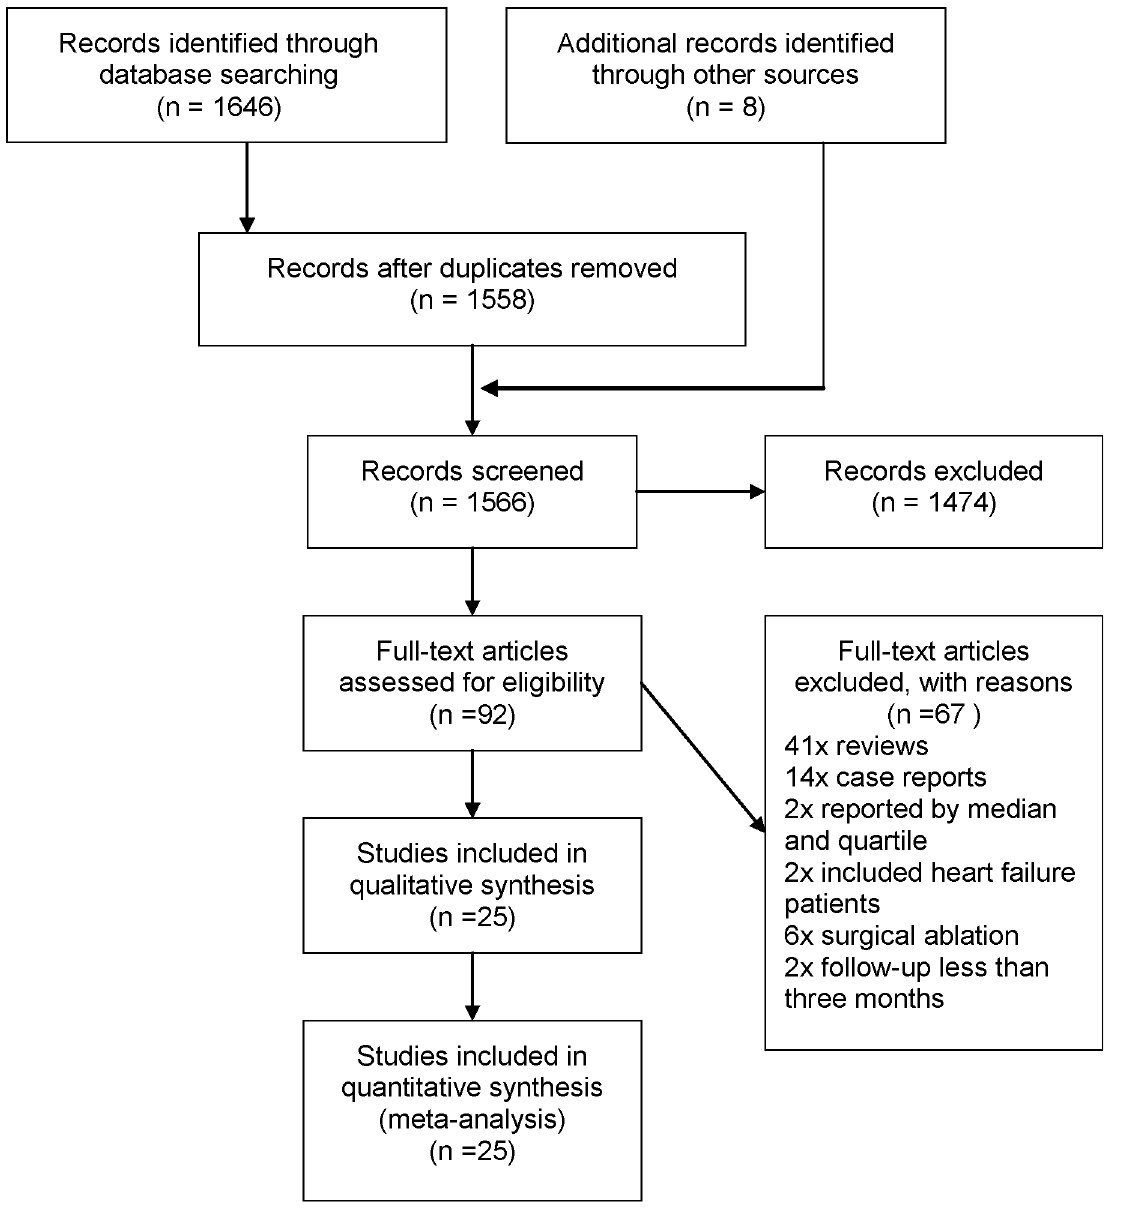
Fig 1. Flow chart of the literature search and study selection